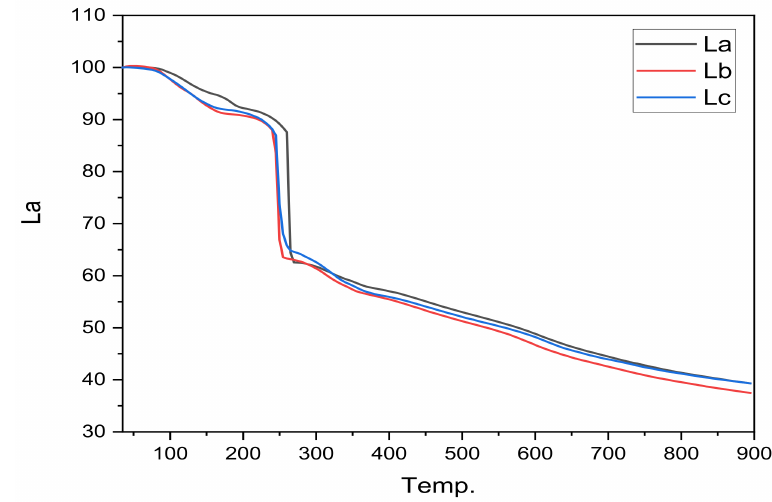
Figure 2. TGA thermograms of the three complexes: La , Lb , and Lc